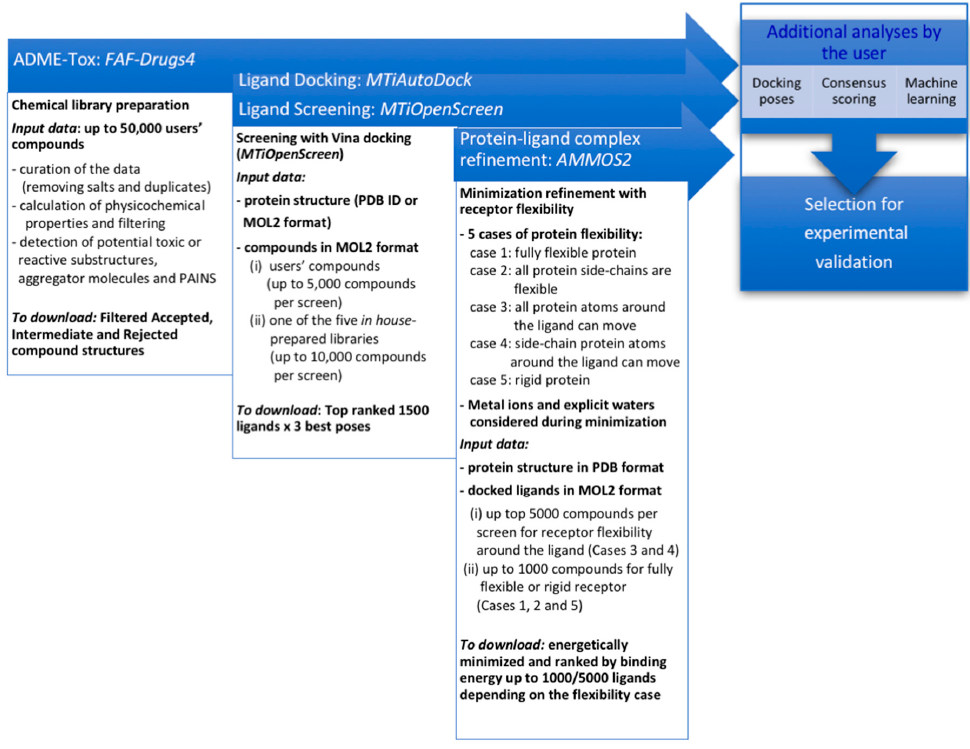
Figure 1. A general workflow of the main steps in the virtual screening protocol employing the three web servers: FAF-Drugs4, MTiOpenScreen, and AMMOS2. The web servers can be used independently or successively depending on the particular needs of the user.